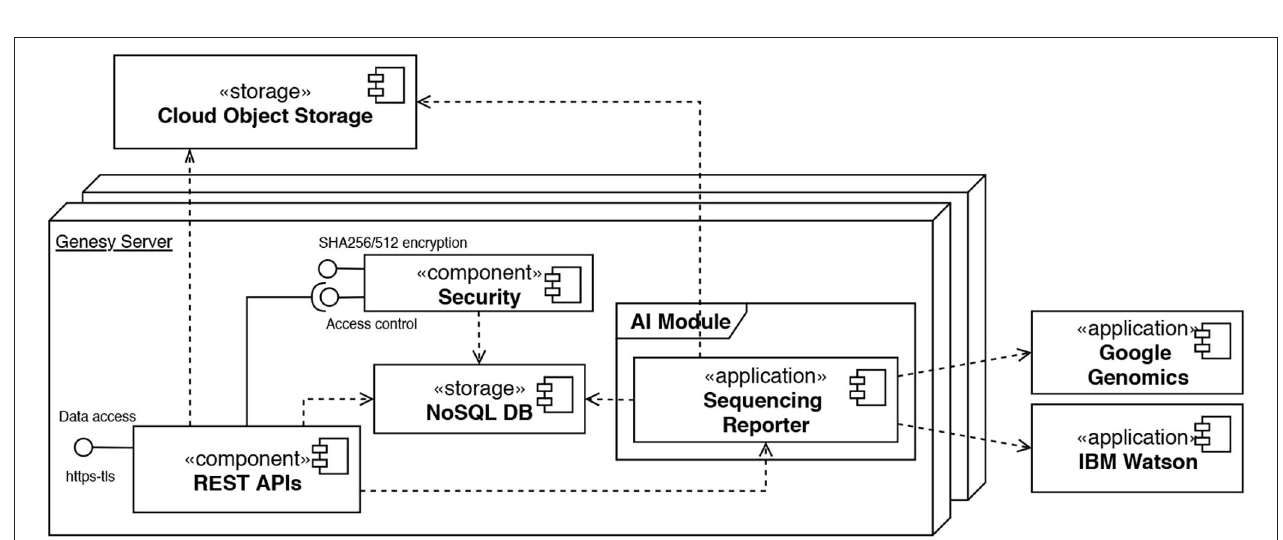
FIGURE 5 | Deployment diagram using the UML notation modeling the architecture of a Genesy peer. Internally, the APIs rely on a security component to manage access control (“Security”) and a local storage (“NoSQL DB”) to store the users’ access metadata. A further component, namely the “Sequencing Reporter” is responsible to analyze the data produced by sequencing and creating